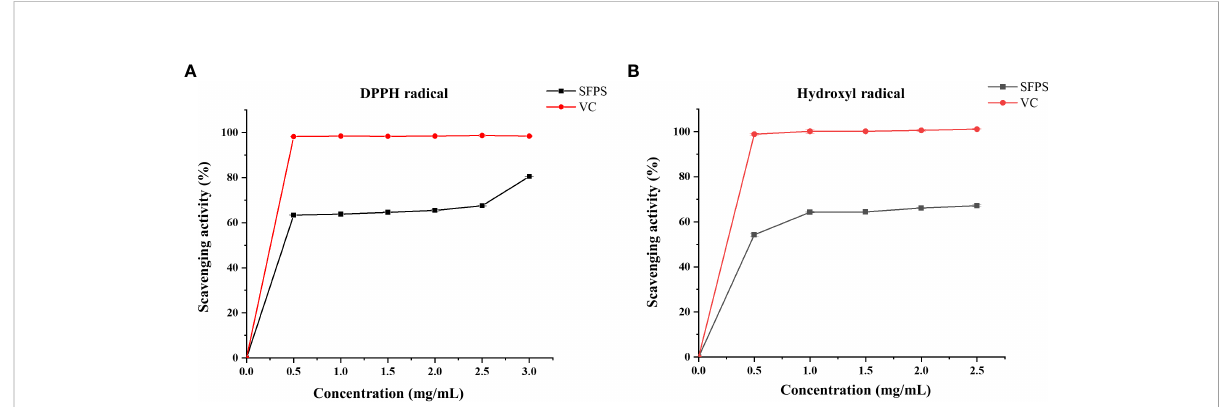
FIGURE 2 The antioxidant activities of SFPS. (A) DPPH scavenging activity (B) Hydroxyl radical scavenging